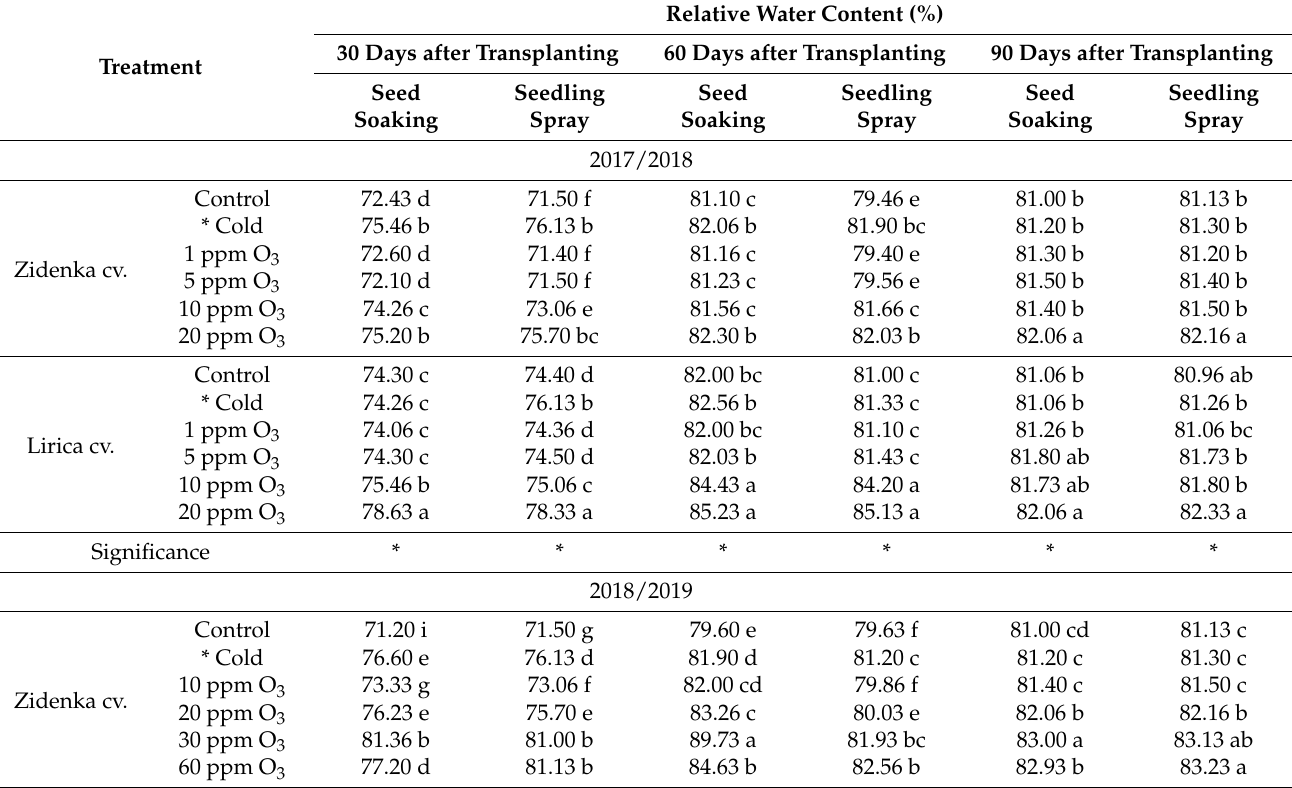
Table 1. Effect of ozone and chilling tolerance pretreatments on relative water content of two sweet pepper hybrids 30, 60, and 90 days after transplanting during the 2017/18 and 2018/19